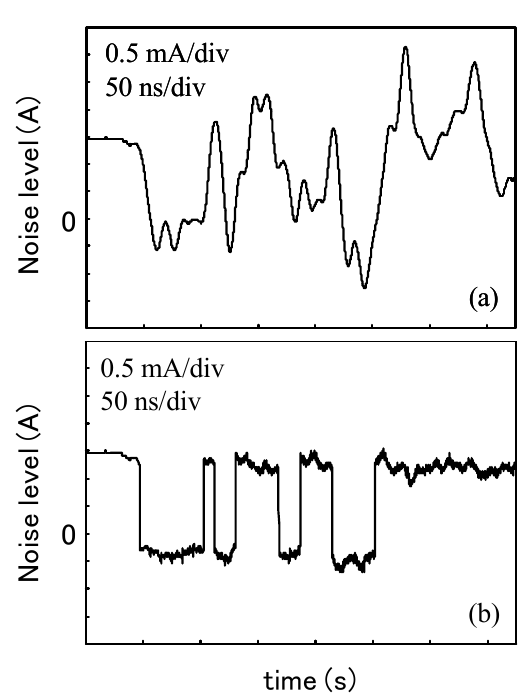
Figure 12. Common-mode noise waveforms for 1280 × 1024 pixels monitor specification: ( a ) before processing, ( b ) after processing.